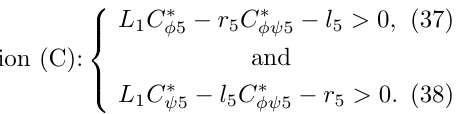
Table 3 Symbol list of the biarticular muscular arrangement Symbol Meaning ˜ i = 5,6 The number of the biarticular muscle l ˜ r ˜ i , i The vectors from the rotational center of each l ˜ r ˜ i , i The lengths of the vector φ ˜ i The angle between the base and the vector ψ ˜ i The angle between the base and the vector θ φ ˜ i The angle between